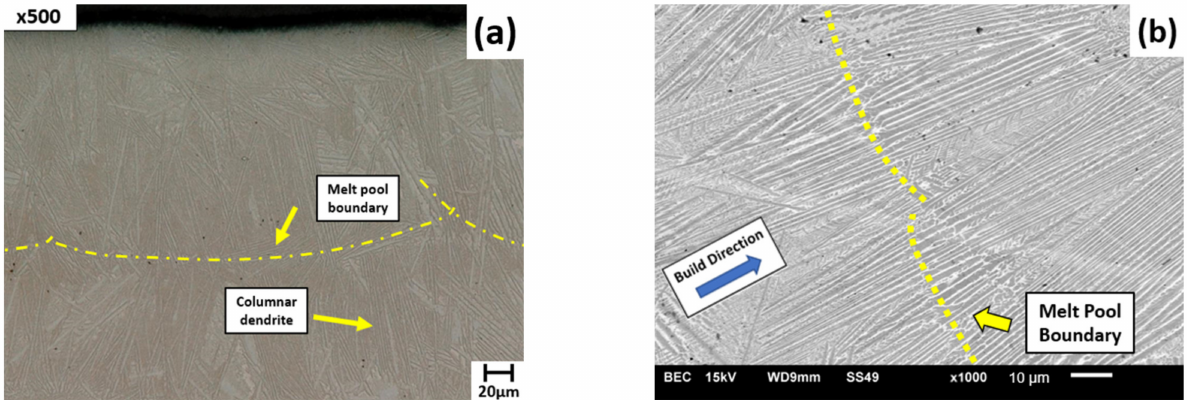
Figure 10. Micrographs of as-fabricated NiTa alloy specimens under ( a ) an optical microscope on the sagittal plane, ( b ) SEM-BSE on the sagittal plane under 1000 ×